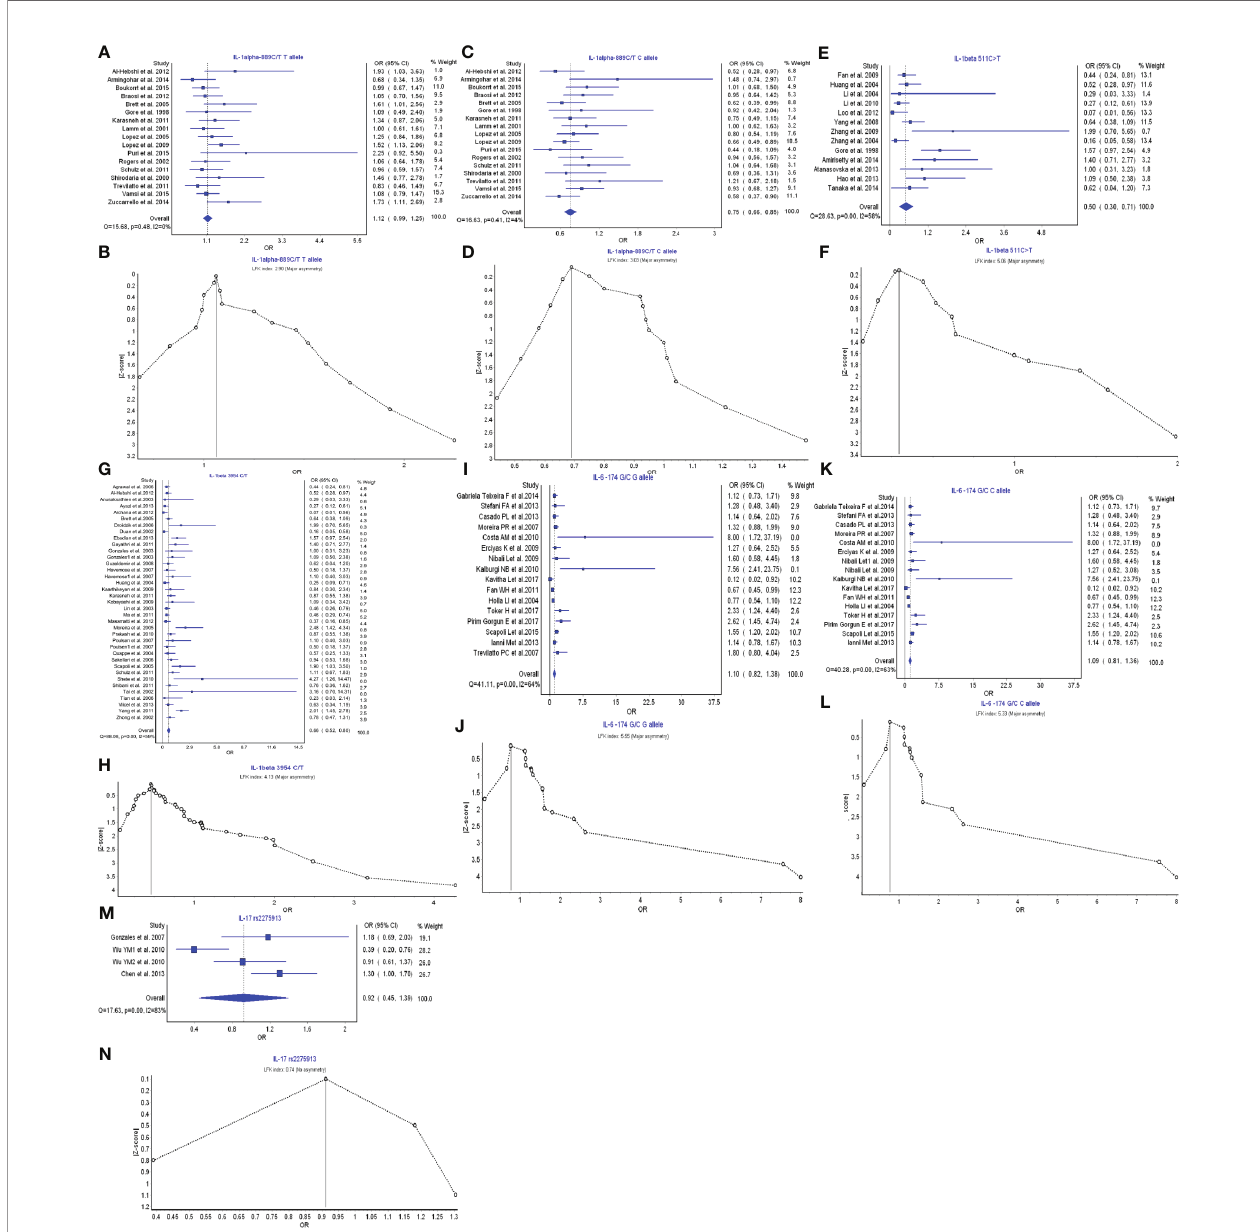
FIGURE 4 | The association of Th17-related cytokine polymorphism with chronic periodontitis. (A) Forest plot of the association of IL-1 a − 889C/T T allele polymorphism with chronic periodontitis. (B) The Doi plot is used to visualize the asymmetry of the association of IL-1 a − 889C/T T allele polymorphism with chronic periodontitis using the LFK index. LFK index zero represents complete symmetry, the limits of symmetry were set at ±1, and values beyond ±1 were inconsistent with symmetry. (C) Forest plot of the association of IL-1 a − 889C/T C allele polymorphism with chronic periodontitis. (D) The Doi plot is used to visualize the asymmetry of the association of IL-1 a − 889C/T C allele polymorphism with chronic periodontitis using the LFK index. (E) Forest plot of the association of IL-1 b − 511C>T polymorphism with chronic periodontitis. (F) The Doi plot is used to visualize the asymmetry of the association of IL-1 b − 511C>T polymorphism with chronic periodontitis using the LFK index. LFK index zero represents complete symmetry, the limits of symmetry were set at ±1, and values beyond ±1 were inconsistent with symmetry. (G) Forest plot of the association of IL-1 b 3954C>T polymorphism with chronic periodontitis. (H) The Doi plot is used to visualize the asymmetry of the association of IL-1 b 3954C>T polymorphism with chronic periodontitis using the LFK index. (I) Forest plot of the association of IL-6 − 174G/ C G allele polymorphism with chronic periodontitis. (J) The Doi plot is used to visualize the asymmetry of the association of IL-6 − 174G/C G allele polymorphism with chronic periodontitis using the LFK index. (K) Forest plot of the association of IL-6 − 174G/C C allele polymorphism with chronic periodontitis. (L) The Doi plot is used to visualize the asymmetry of the association of IL-6 − 174G/C C allele polymorphism with chronic periodontitis using the LFK index. (M) Forest plot of the association of IL- 17 rs2275913 polymorphism with chronic periodontitis. (N) The Doi plot is used to visualize the asymmetry of the association of IL-17 rs2275913 polymorphism with chronic periodontitis using the LFK index. LFK index zero represents complete symmetry, the limits of symmetry were set at ±1, and values beyond ±1 were inconsistent with